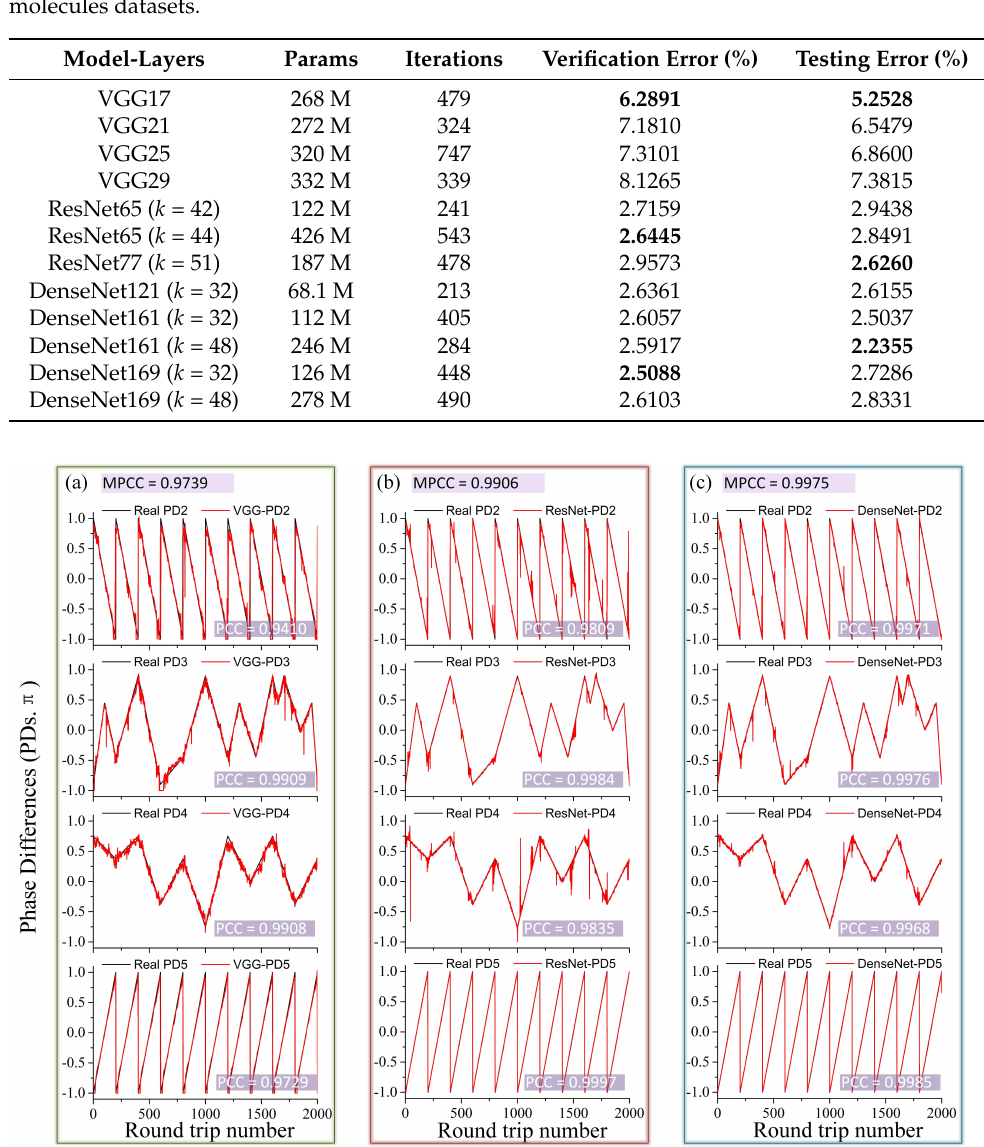
Figure 5. Relative phase difference (PD2-PD5). ( a ) The real PDs and VGG-PDs. ( b ) The real PDs and ResNet-PDs. ( c ) The real PDs and